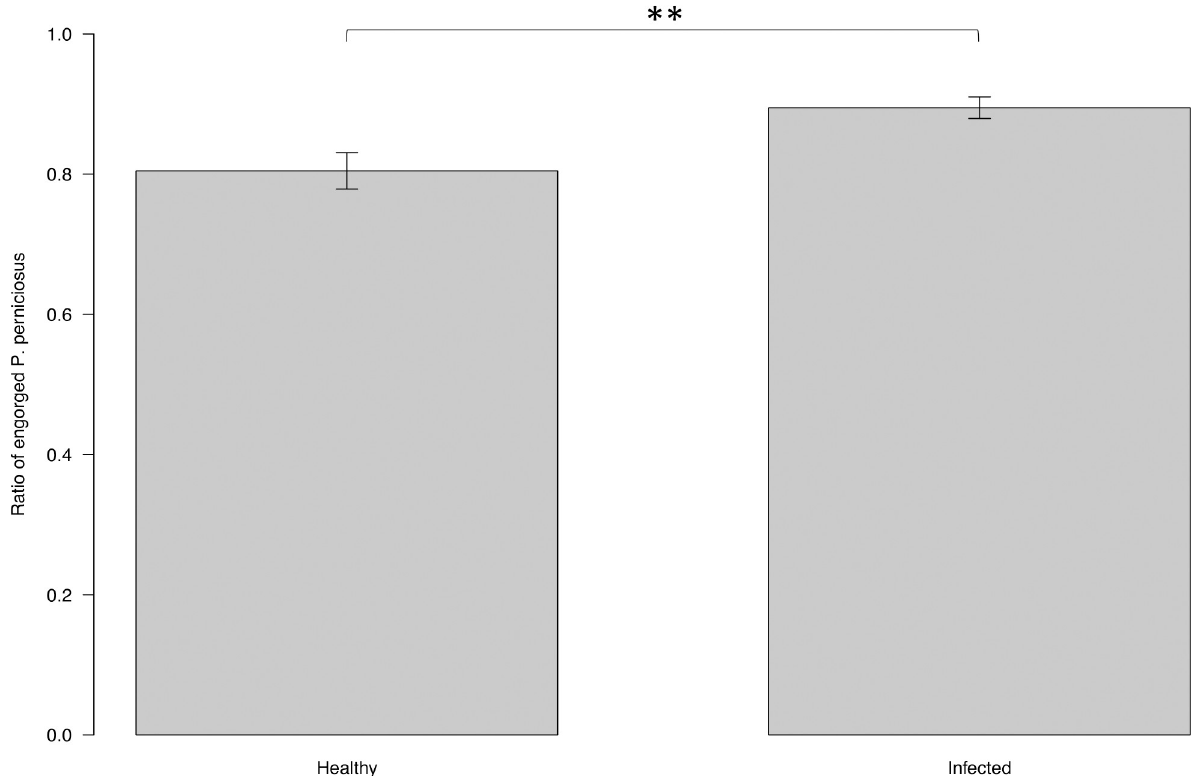
Fig 4. Proportion of females P . perniciosus fed on uninfected and on infected dogs under laboratory conditions. Y axis represents the proportion of engorged females collected from the cage baited with infected dog, and from the cage baited with uninfected dog. X axis represents the infection status of the dogs. Boxes are limited by the minimal and maximal value. Error bars correspond to the standard error. Significance code: p � 0.01 ��